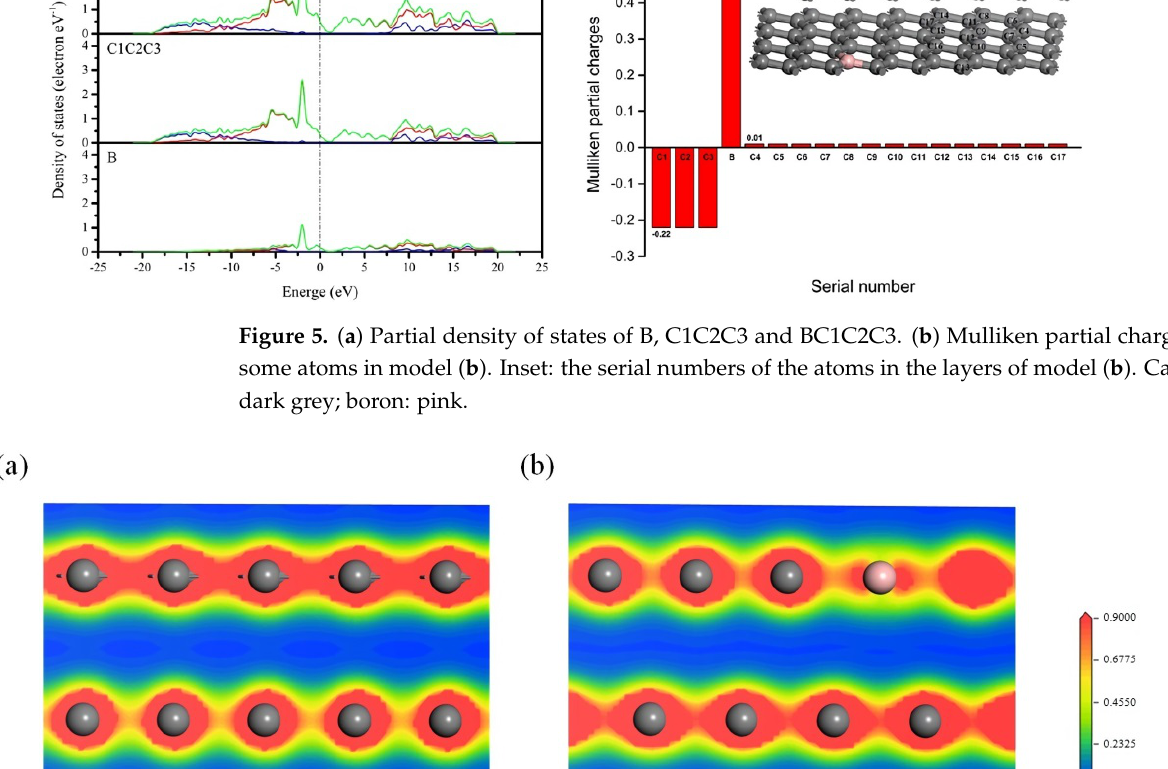
Figure 6. Charge density diagram within the (010) plane of ( a ) graphite and ( b ) boron-doped graphite across the boron atoms. Carbon: dark grey, boron: pink.